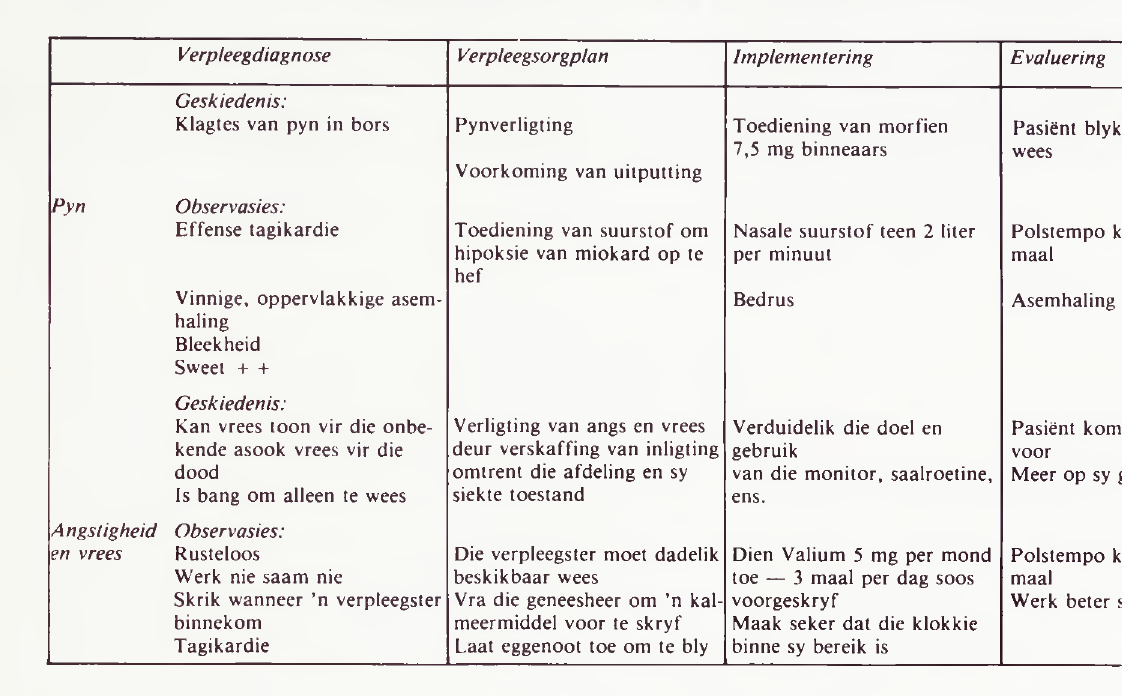
Tabel 1: Implementering van die Verpleegproses by ’n Pasiënt met M iokardiale